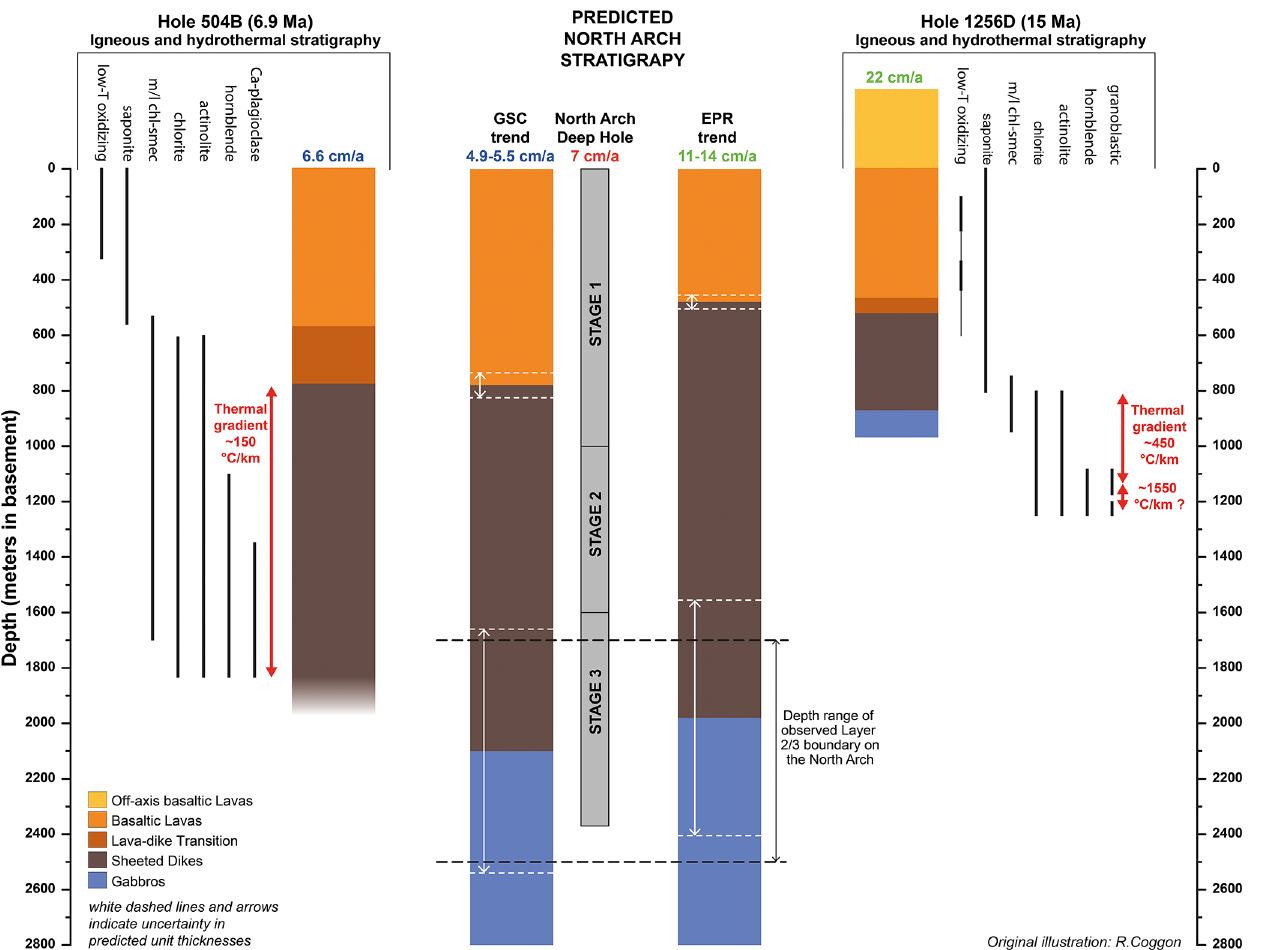
Figure 3. Holes 504B and 1256D rock type hydrothermal stratigraphies, and the predicted North Arch rock type stratigraphy (Phipps Morgan and Chen, 1993). The significantly different sheeted dike thicknesses at holes 504B and 1256D resulted in their dramatically different thermal regimes. The North Arch is located on crust formed at a spreading rate intermediate between 504B (6.6cma − 1 ) and 1256D (22cma − 1 ). Distinct ocean crustal architectures are predicted on the basis of seismic observations from the Galapagos Spreading Center (GSC) and the East Pacific Rise (EPR). Given the North Arch spreading rate of ∼ 7cma − 1 , we hypothesize that the crustal architecture will be similar to that predicted from the GSC trend. Holes 504B and 1256D stratigraphies and mineral distributions after Teagle et al.